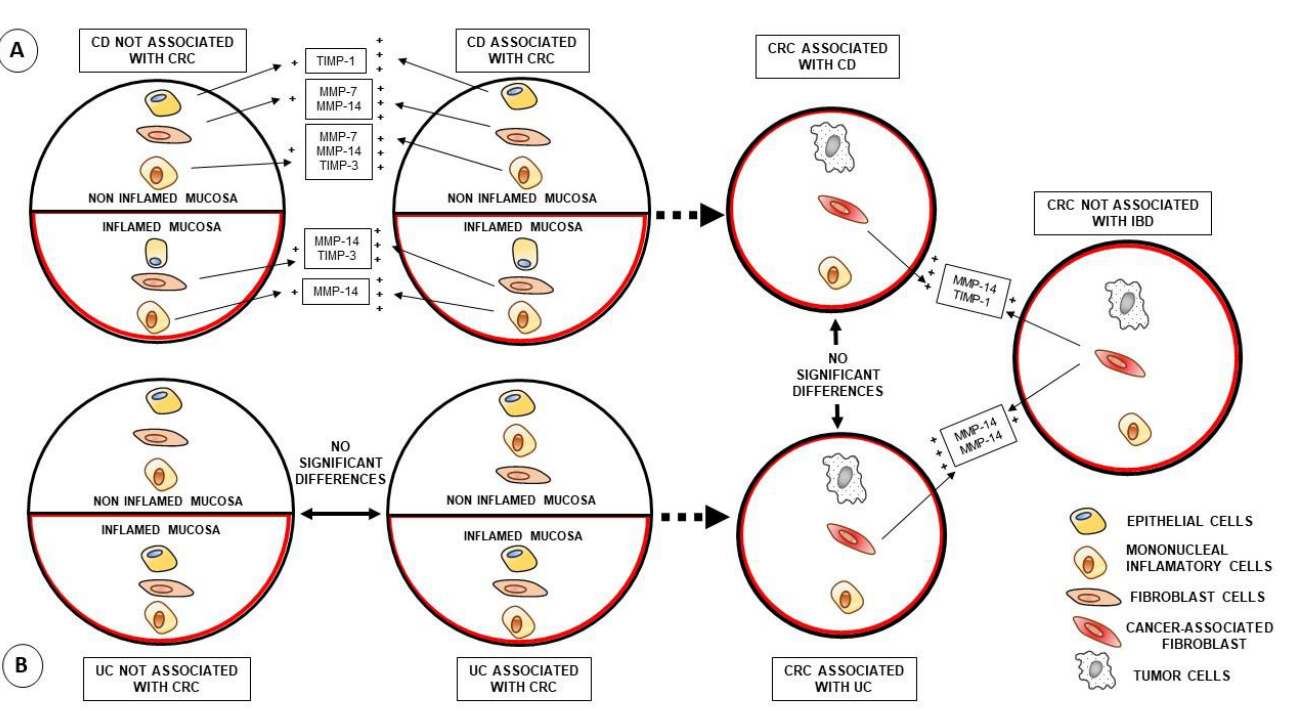
Figure 2. Schematic representation of the hypothesis of the evolution of the expression of metalloproteases and TIMP to cancer lesions in ( A ) Crohn’s disease (CD) and ( B ) ulcerative colitis (UC). The first column on the left shows IBD-not- associated CRC patients, and the first column on the right shows IBD-associated CRC patients (group A: CD, group B: UC). The upper part of both columns shows the highest expression of the investigated factors in patients with CD associated with CRC. Further to the right the strongest expression of the agents studied in IBD-associated CRC patients compared to CRC sporadic cases can be observed. +: expression; +++: higher expression